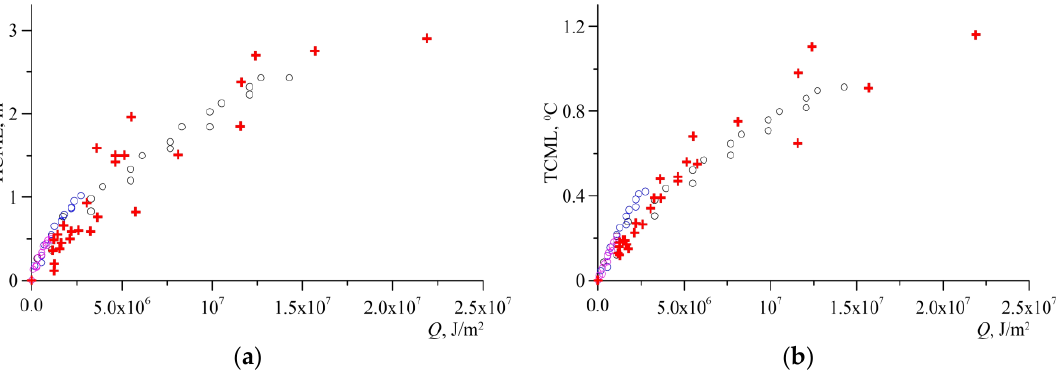
Figure 8. Dependence of the CML on lower boundary depth HCML ( a ), temperature TCML and ( b ) increments in cumulative heating Q : black symbols — Variant 1, blue — Variant 2, purple — Variant 3, red symbols — observational data.